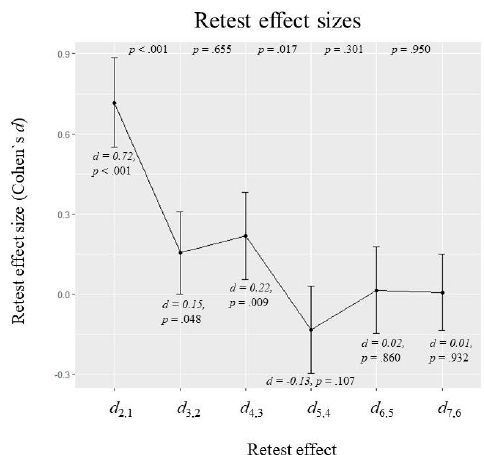
Figure 6. Estimated means of the standardized latent difference variables of the full interference model, which can be interpreted as retest effect sizes in terms on Cohen’s d between two successive test administrations. To obtain these parameters, the model was identified by setting the variances of the latent variables to 1. d 2,1 represents the retest effect from the first to the second test administration, etc. Error-bars indicate two-tailed 95% confidence intervals. p -values at the top refer to the differences between the respective successive retest effects.